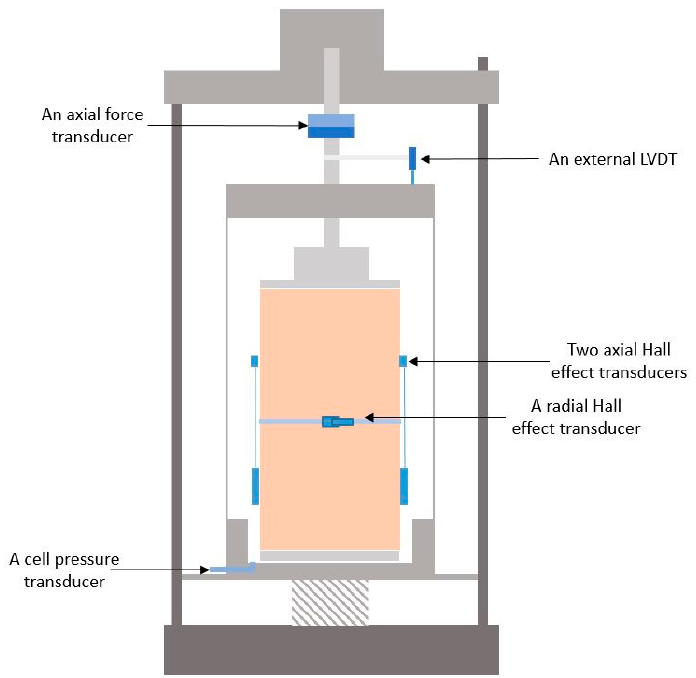
Figure 6. Schematic view of the triaxial cell placed in the loading frame and the transducers.